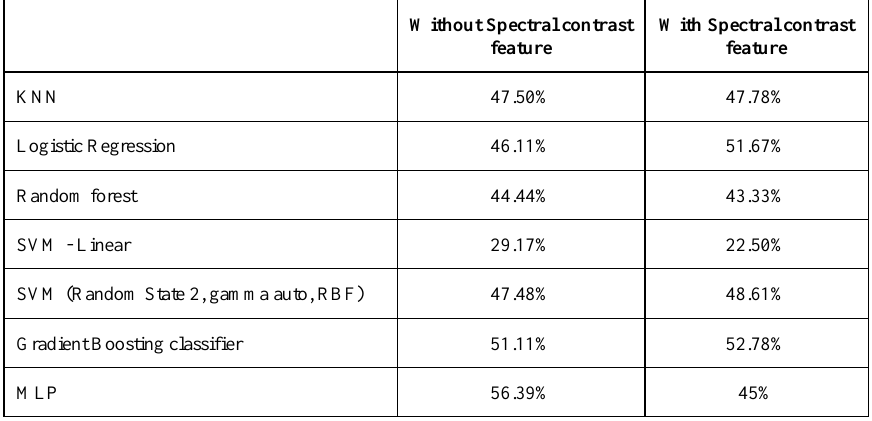
Table 3. Accuracy for other classification algorithms with and without spectral contrast feature